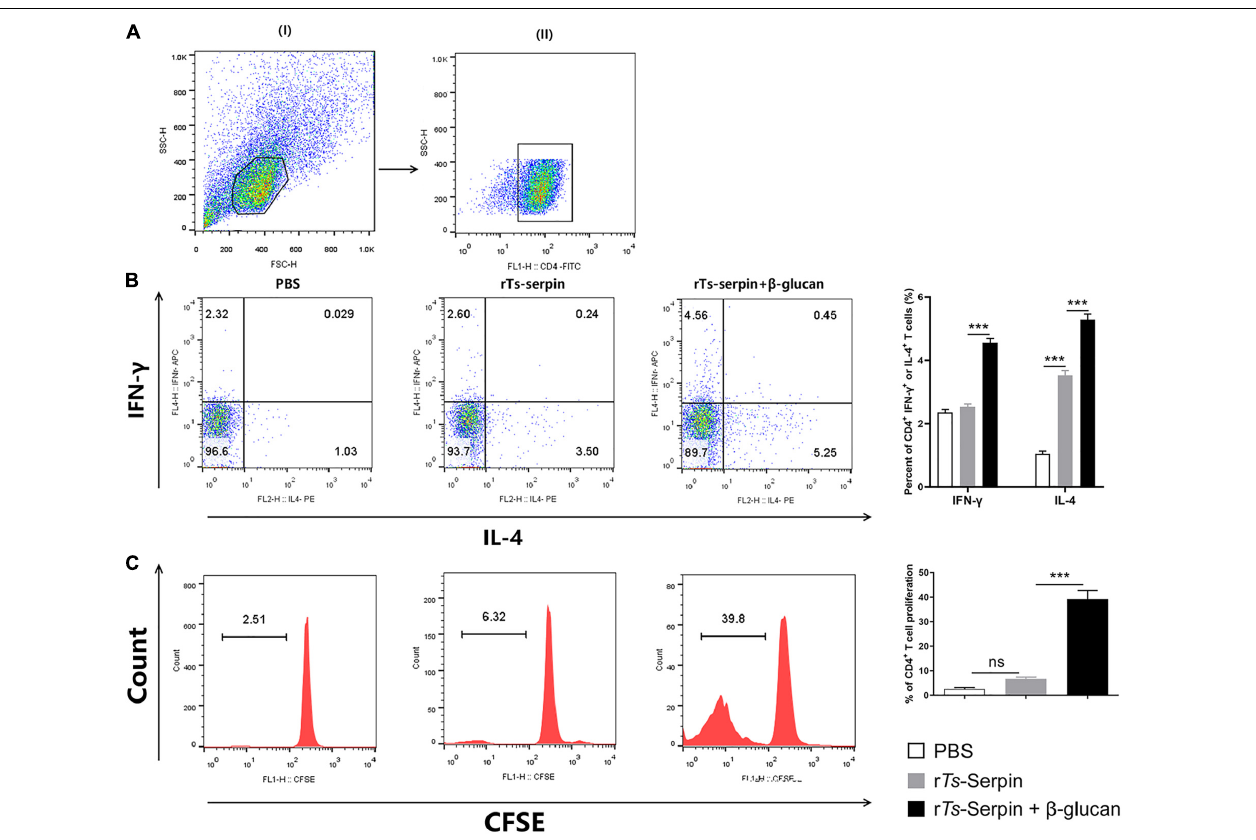
FIGURE 5 | CD4 + T cells response induced by β -glucan + rTs-Serpin –treated DCs. The purity of CD4 + T cells were analysis by FACS after magnetic sorting using anti-CD4 magnetic beads. The purified CD4 + T cells had > 90% purity. DCs (1 × 10 5 /well) and CD4 + T cells (1 × 10 6 /well) were cocultured for 72 h with OVA (1 mg/mL), then cells were incubated with 10 mg/mL Brefeldin A, 50 ng/mL phorbol 12-myristate 13-acetate (PMA) and 750 ng/mL Ionomycin for 6 h at 37 ◦ C. (A) (I) gating on viable cells and (II) gating on CD4 + cells. (B) Percentage of CD4 + IFN- γ + and CD4 + IL-4 + T cells were determined by flow cytometry. (C) CD4 + T cells were stained with CFSE before co-culture with DCs. The proliferation of CD4 + T cells were determined by flow cytometry. Results are shown as mean ± SD ( n = 3) of three different experiments. * P < 0.05, ** P < 0.01, *** P < 0.001 as indicated by line (one-way ANOVA with Tukey’s post